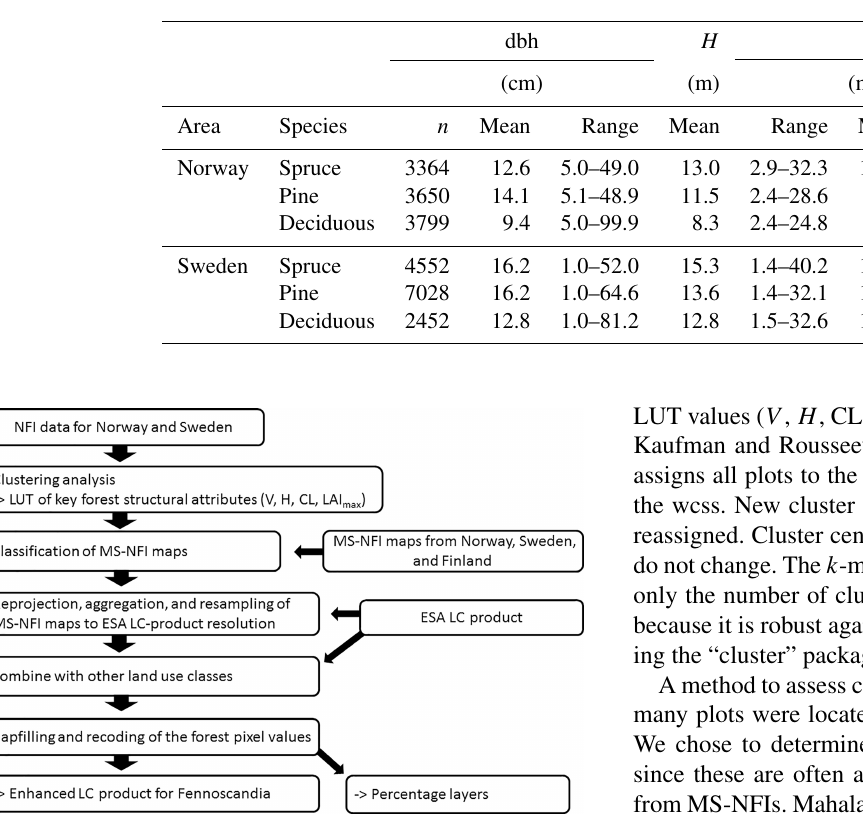
Table 1. Descriptive statistics for the National Forest Inventory (NFI) data. Abbreviations: n is the number of sample plots, dbh is diameter at breast height, H is basal-area-weighted mean tree height (i.e., Lorey’s height), and V is total stem volume.